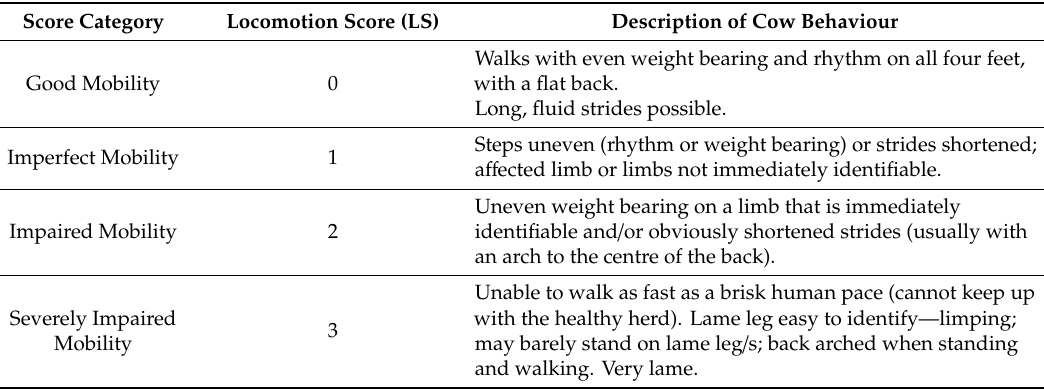
Table 1. Agriculture and Horticulture Development Board (AHDB) Dairy mobility scoring